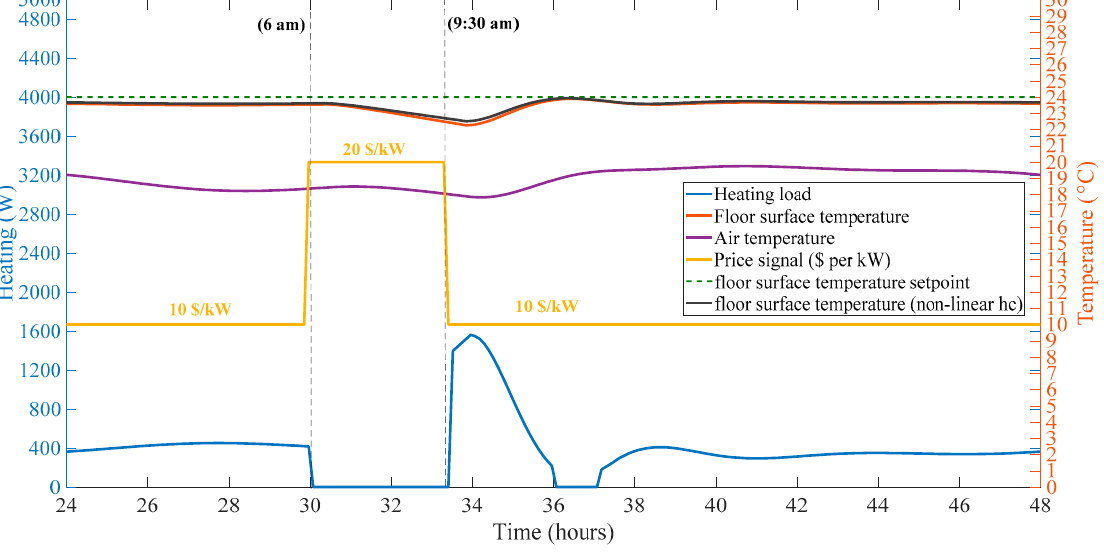
Figure 8. Reactive response to sudden increase in the price signal.